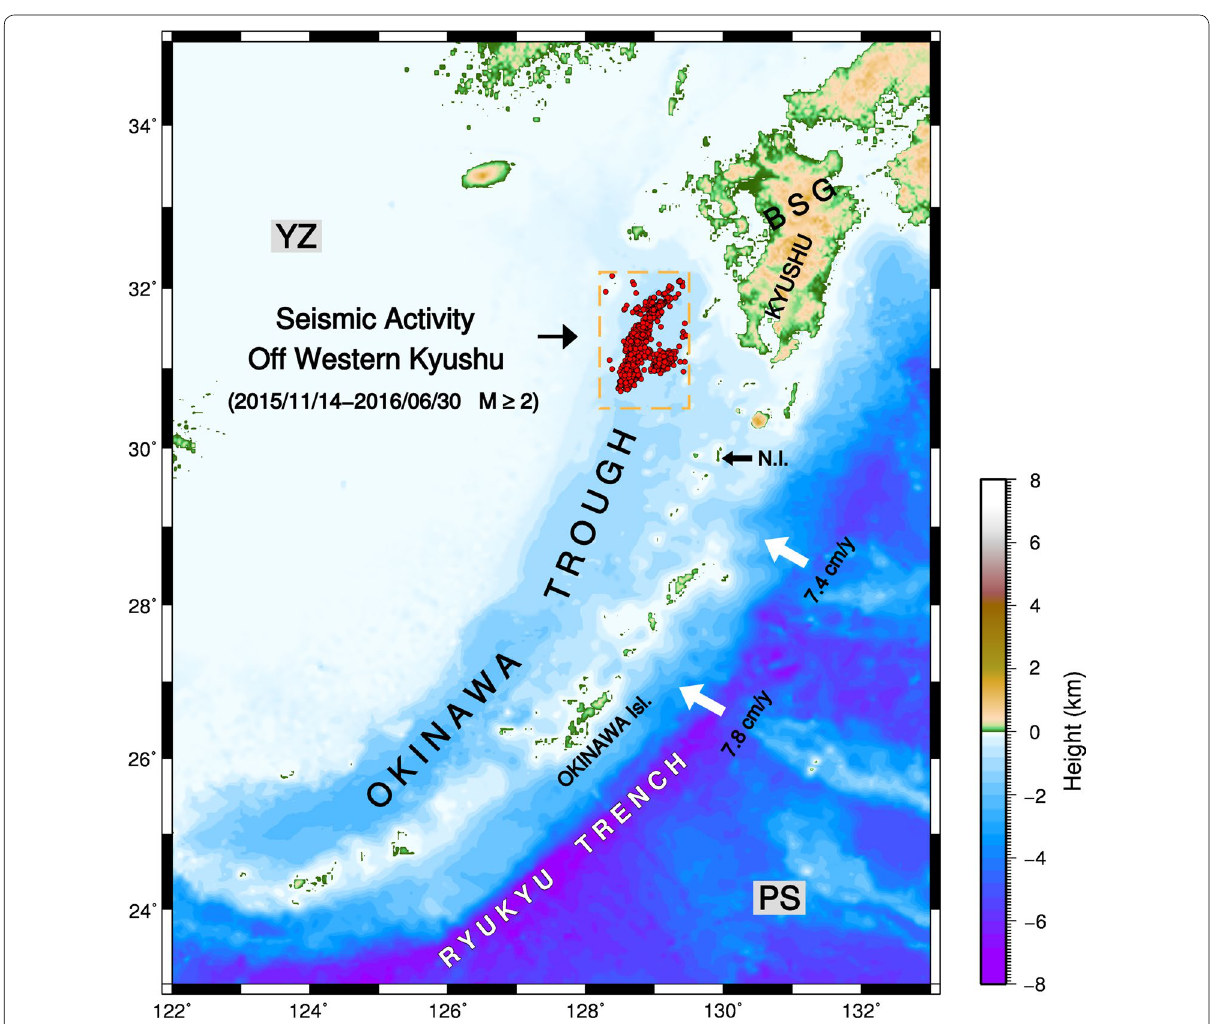
Fig. 1 Map of the Ryukyu Arc. The Okinawa Trough is a back-arc basin accompanying the Ryukyu Trench where the Philippine Sea (PS) plate is subducting beneath the Yangtze (YZ) plate. White arrows denote the motion of the PS plate relative to the YZ plate (DeMets et al. 2010). Red circles indicate the seismic activity studied in the northern Okinawa Trough from 11/14/2016 to 06/30/2016 (JST), with M JMA unified focal parameters determined by JMA are used. “N.I.” denotes Nakanoshima